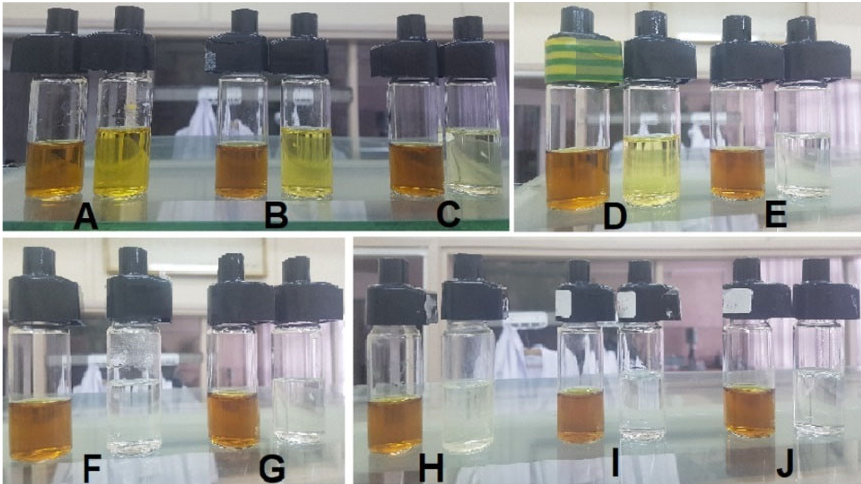
Figure 2. Cells with collected acceptor and donor fluid after silver nanoparticle diffusion process using different filters: ( A )—one filter F118; ( B )—one filter F63; ( C )—one filter F1; ( D )—two filters F118 and F63; ( E )—combination of three filters F118, F63, and F1; ( F )—two filters F1; ( G )—three filters F1; ( H )—one filter F9*; ( I )—two filters F9*; ( J )—three filters F9*.